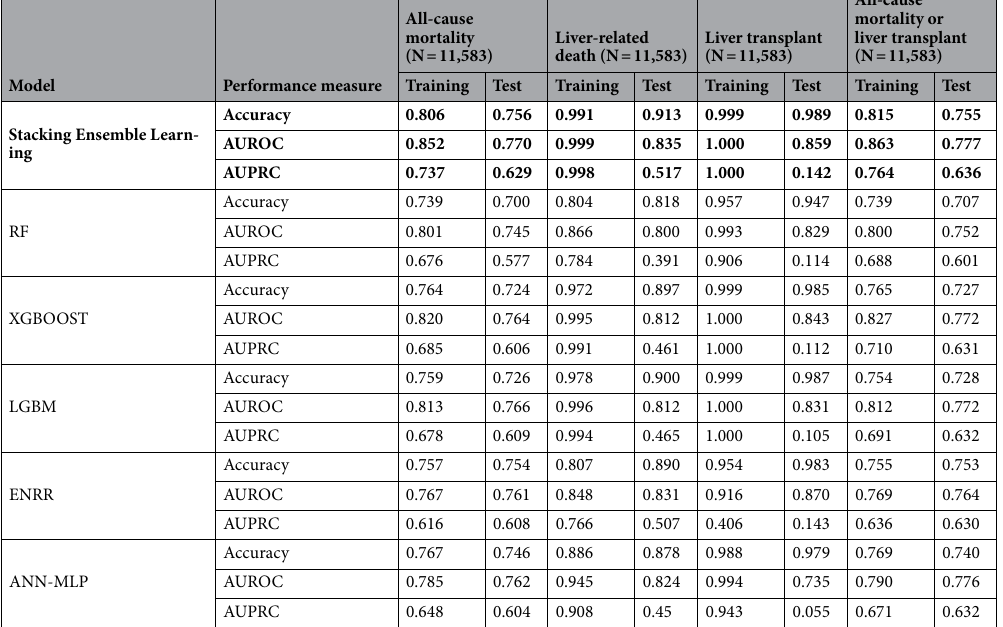
Table 7. Overall predictive model performance measures of stacking ensemble and each base model used in the ML training in patients with any liver disease. Mean model performance measures were reported in the Training Set and the Test Set, respectively. AUPRC = area under the precision-recall curve, AUROC = area under the receiver operating characteristic, RF = random forest, XGBOOST = extreme gradient boosting, LGBM = light gradient boosting, ENRR = elastic net regularized regression, ANN-MLP = artificial neural network multilayer perceptron. Model performance measures from the stacking ensemble learning model are in